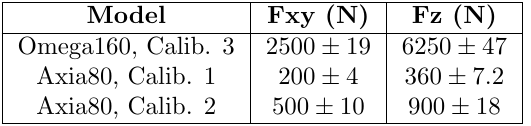
Table 1: Measuring range and accuracy of ATI force/- torque sensors ATI Industrial Automation (2018b)ATI Industrial Automation